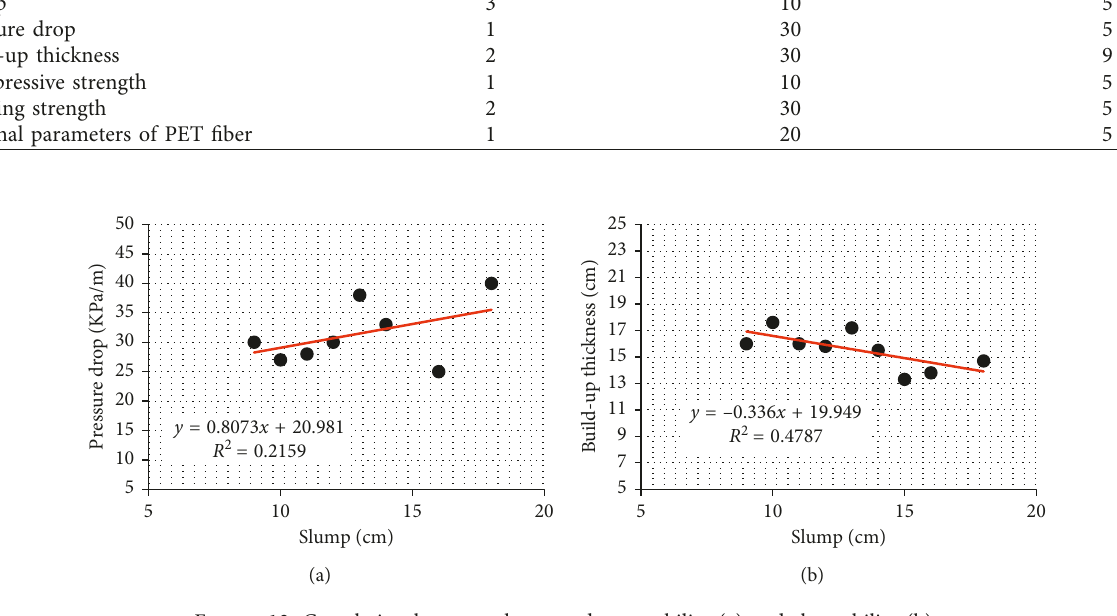
Figure 12: Correlation between slump and pumpability (a) and shootability (b).